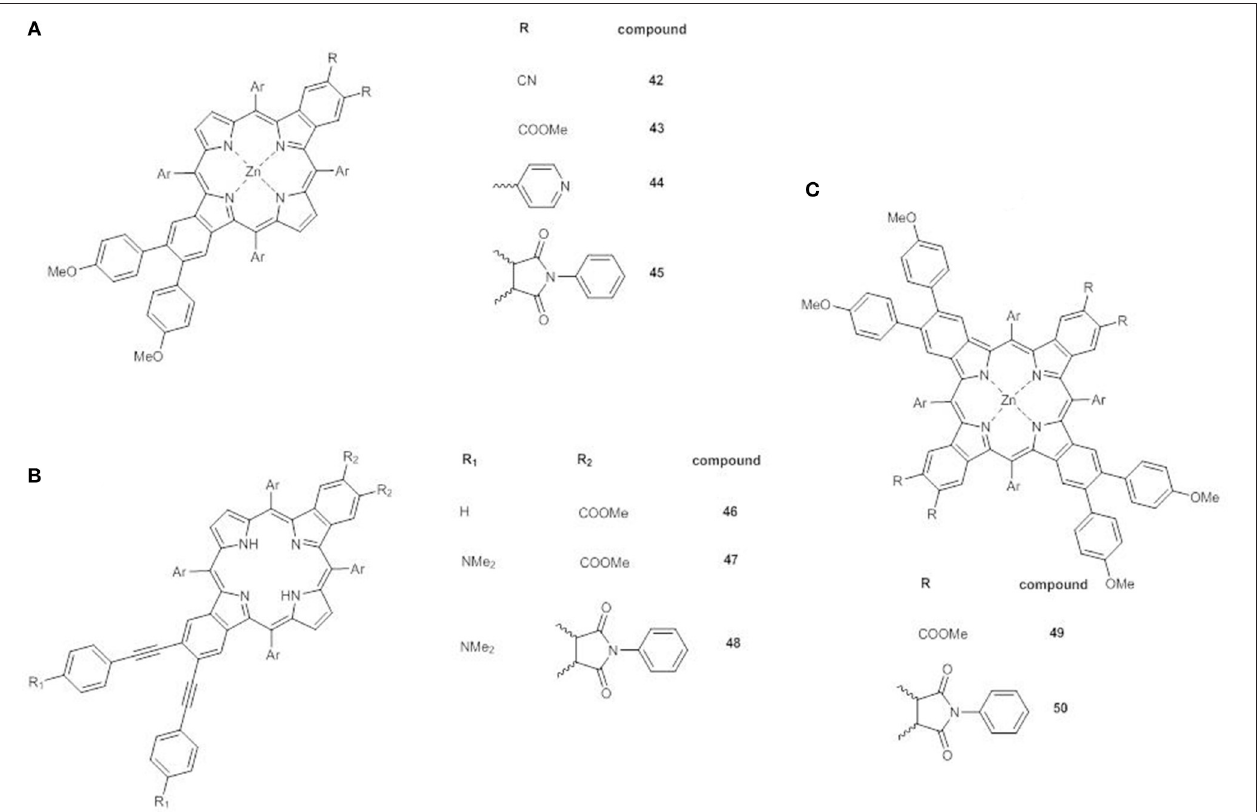
FIGURE 15 | (A) β -functionalized dibenzoporphyrins 42-45 ; (B) β -functionalized dibenzoporphyrins with ethynylphenyl bridges 46-48 ; (C) β -functionalized tetrabenzoporphyrins 49-50